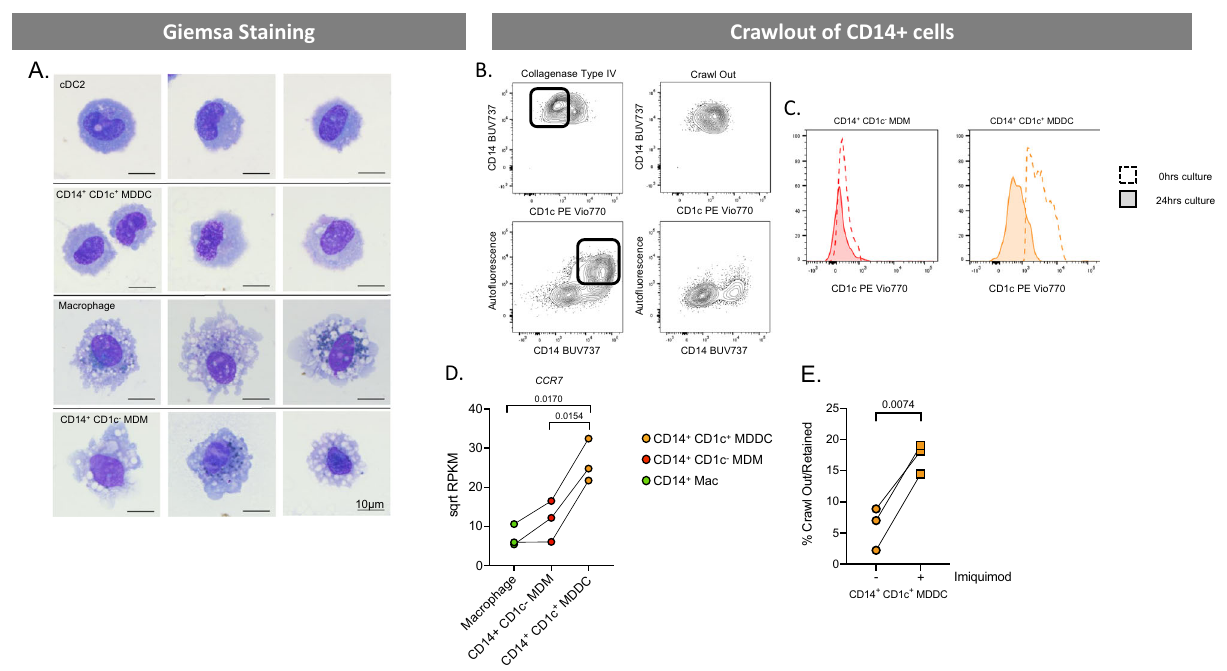
Fig. 4 Morphological and migratory properties of CD14-expressing human tissue mononuclear phagocytes. A Human dermal MNPs were isolated from abdominal skin by collagenase digestion, with each de fi ned subset FACS isolated and Giemsa stained to investigate morphology. B The migratory capabilities of CD14-expressing cells (macrophages, CD14 + CD1c − cells, CD14 + CD1c − cells). From a single donor dermal sheets were cultured for 24 h and supernatant collected for cells which had undergone spontaneous migration (crawl out), tissue was then collagenase digested to liberate cells which did not undergo spontaneous migration. Contour plots show the phenotype of cells which crawled out compared to those which remained within the tissue, box highlighting cells which remained in tissue. C From a separate donor CD14 + CD1c − cells and CD14 + CD1c + cells were FACS isolated following collagenase digestion and cultured for 0 h (un fi lled, dotted histogram) and 24 h ( fi lled, continuous histogram) to determine the difference in CD1c expression on these cells before and after maturation. D Gene expression of chemokine receptor CCR7 determined by RNAseq for CD14-expressing MNPs from abdominal skin ( n = 3). The square root of reads per kilobase of transcript, per million mapped reads (RPKM) is plotted, with each donor represented by an individual dot and lines connecting donors. Statistics were generated using RM one-way ANOVA with Holm – Sidak ’ s multiple comparisons with adjusted P values shown. E The percentage of CD14 + CD1c + cells which had undergone spontaneous migration compared to cells which remained within the tissue was calculated following overnight culture with or without the TLR7 agonist imiquimod. Statistics were calculated using a two-tailed paired T